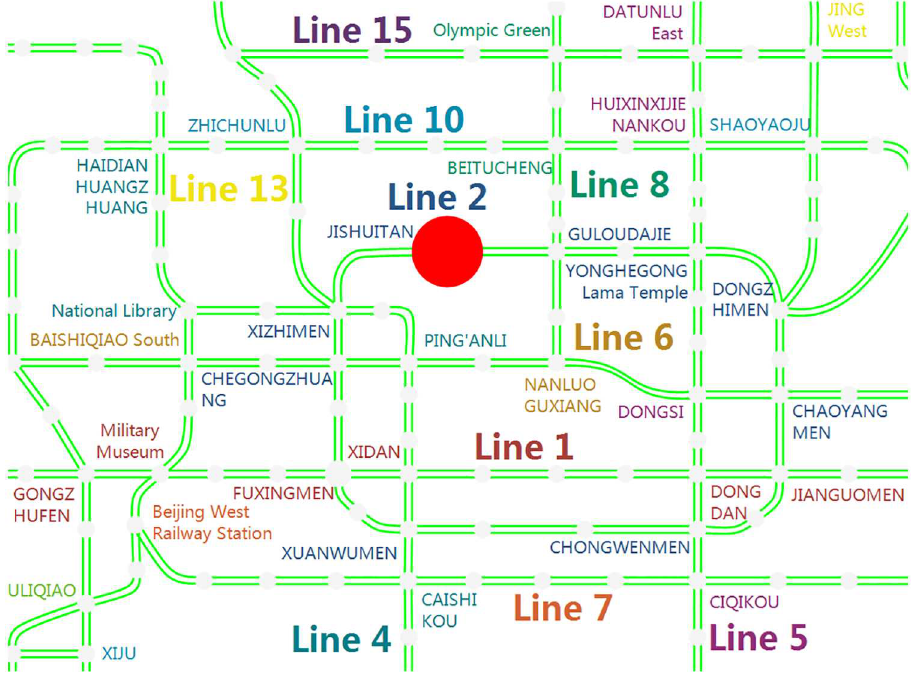
Fig 8. The location of JISHUITAN station in the Beijing rail transit network. The red point is JISHUITAN station.